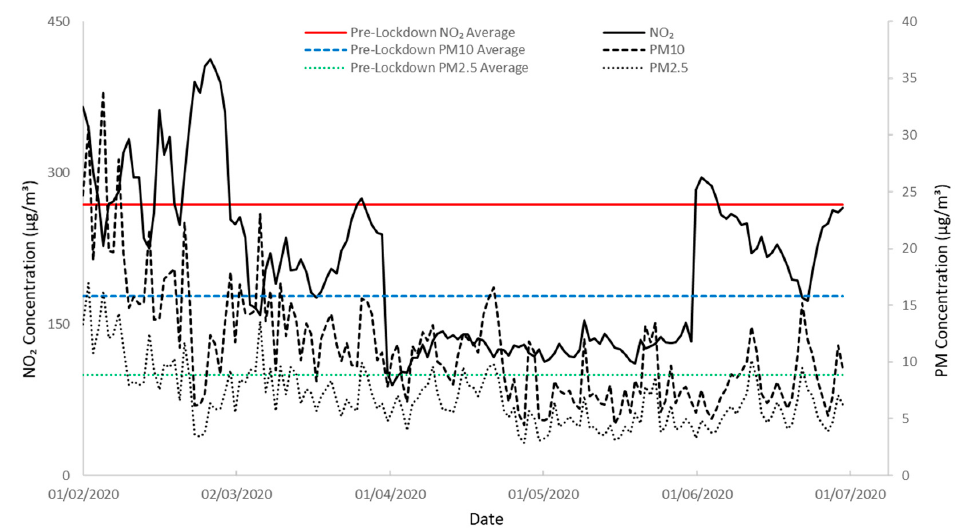
Figure 6. Dual y -axis timeseries plot of 24 h NO 2 and PM 10 and PM 2.5 concentrations at Platform 10B from 1 February to 30 June 2020 with NO 2 concentration on the left vertical axis whist PM concentration is on the right vertical axis. The horizontal solid, dashed, and stippled lines represent pre-lockdown average concentrations for the respective pollutants calculated between 1 February to 23